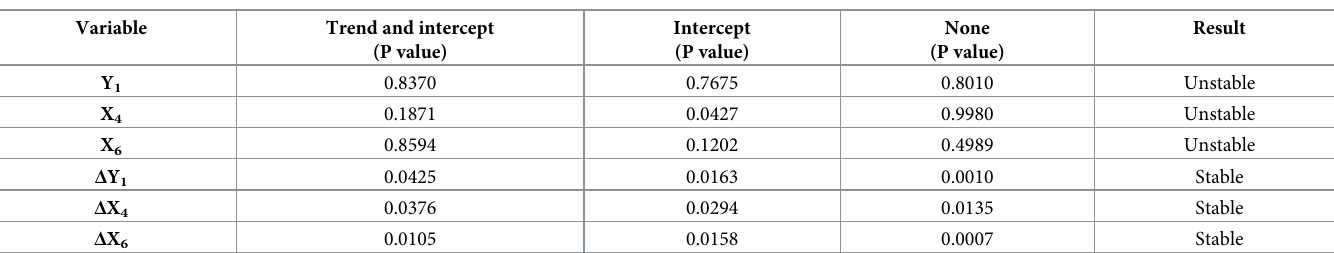
Table 5. ADF unit root test results.